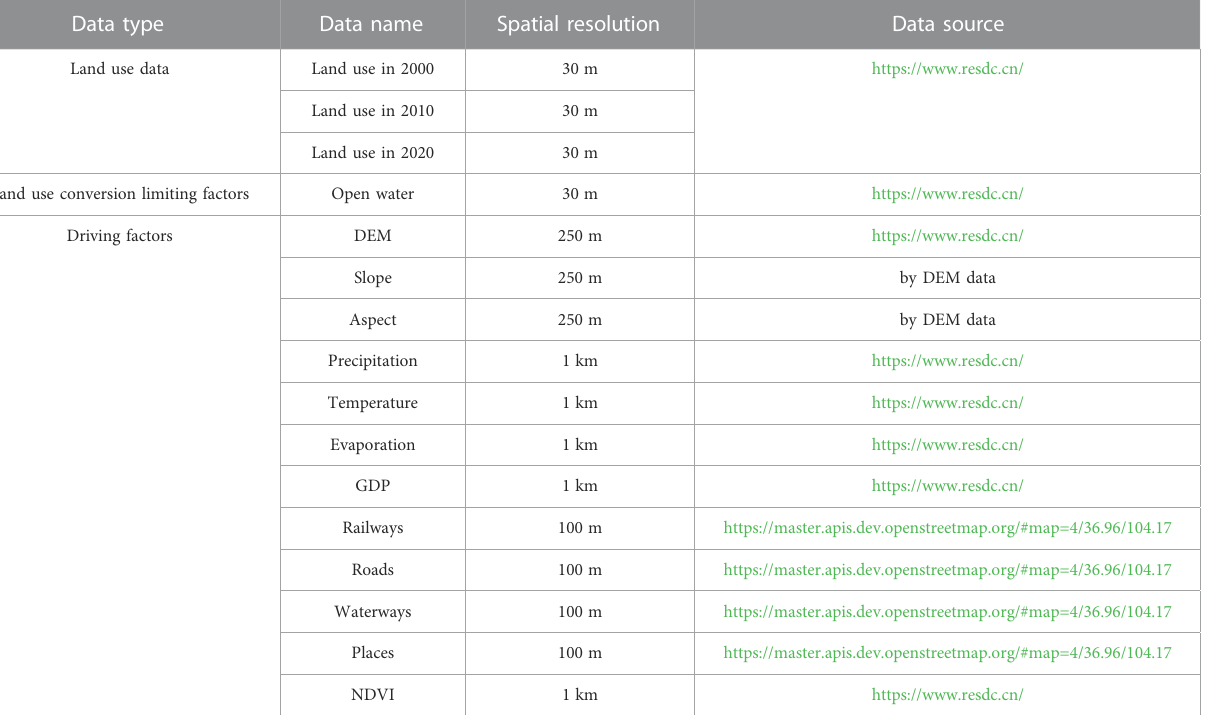
TABLE 1 Description of the driving factor